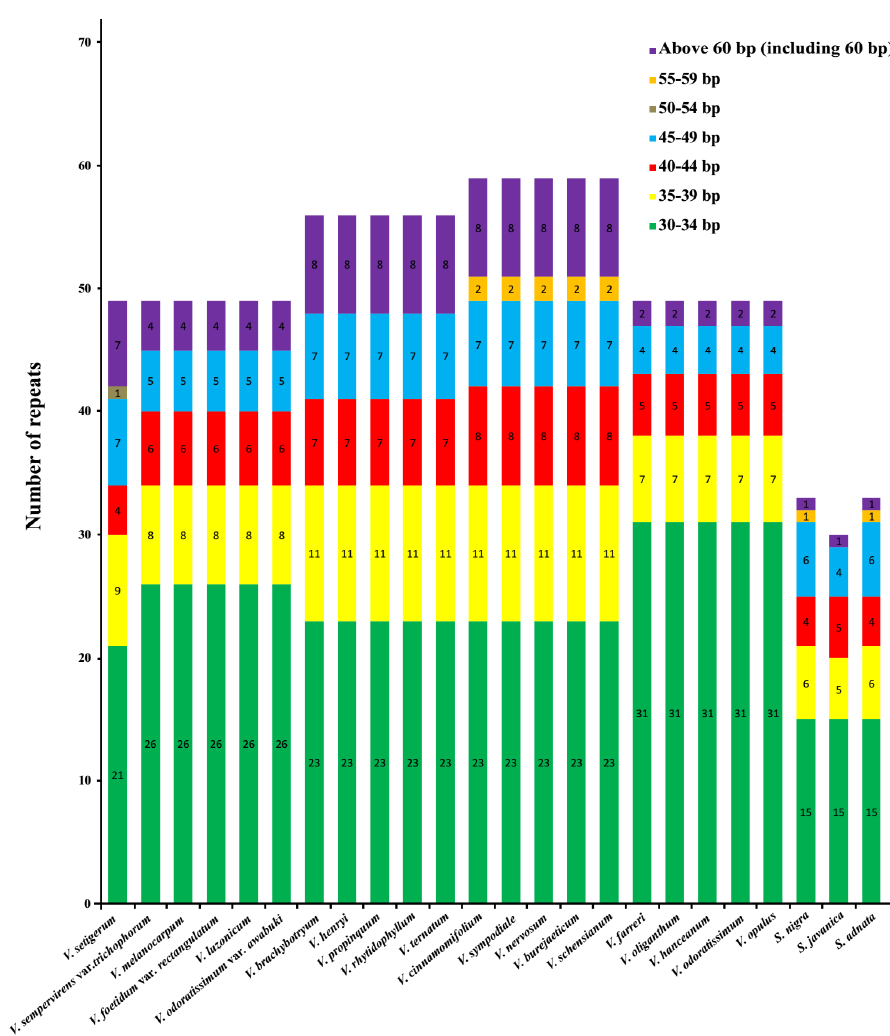
Figure A2. Compositions of the repeats in 24 Adoxaceae species. Repeats with different lengths are indicated in different colors.